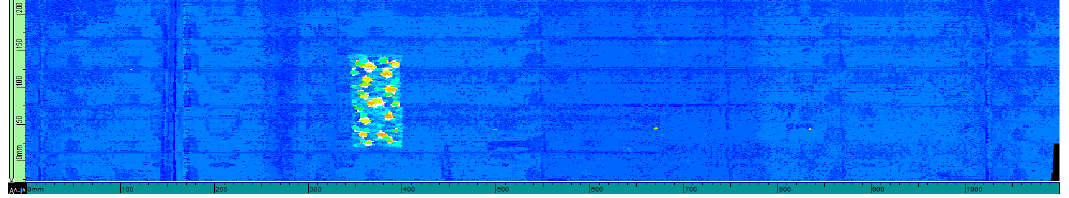
Figure 11. C-scan image of the circular material.